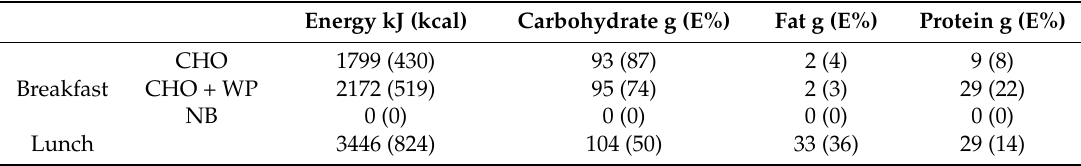
Table 1. Energy and macronutrient composition of breakfast and lunch test